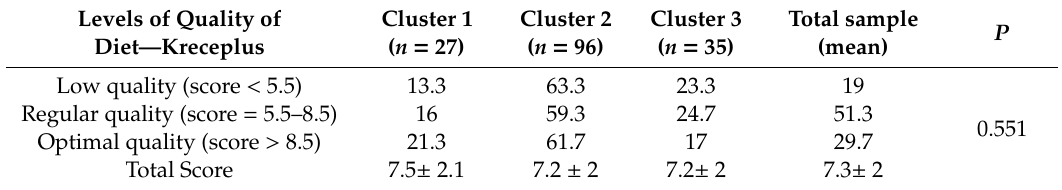
Table 4. Percentage of children in each cluster with adequacy of the food intake to the Mediterranean diet measured by scores based in Krece Plus questionnaire, by clusters. Levels of Quality of Diet—Kreceplus Low quality (score <